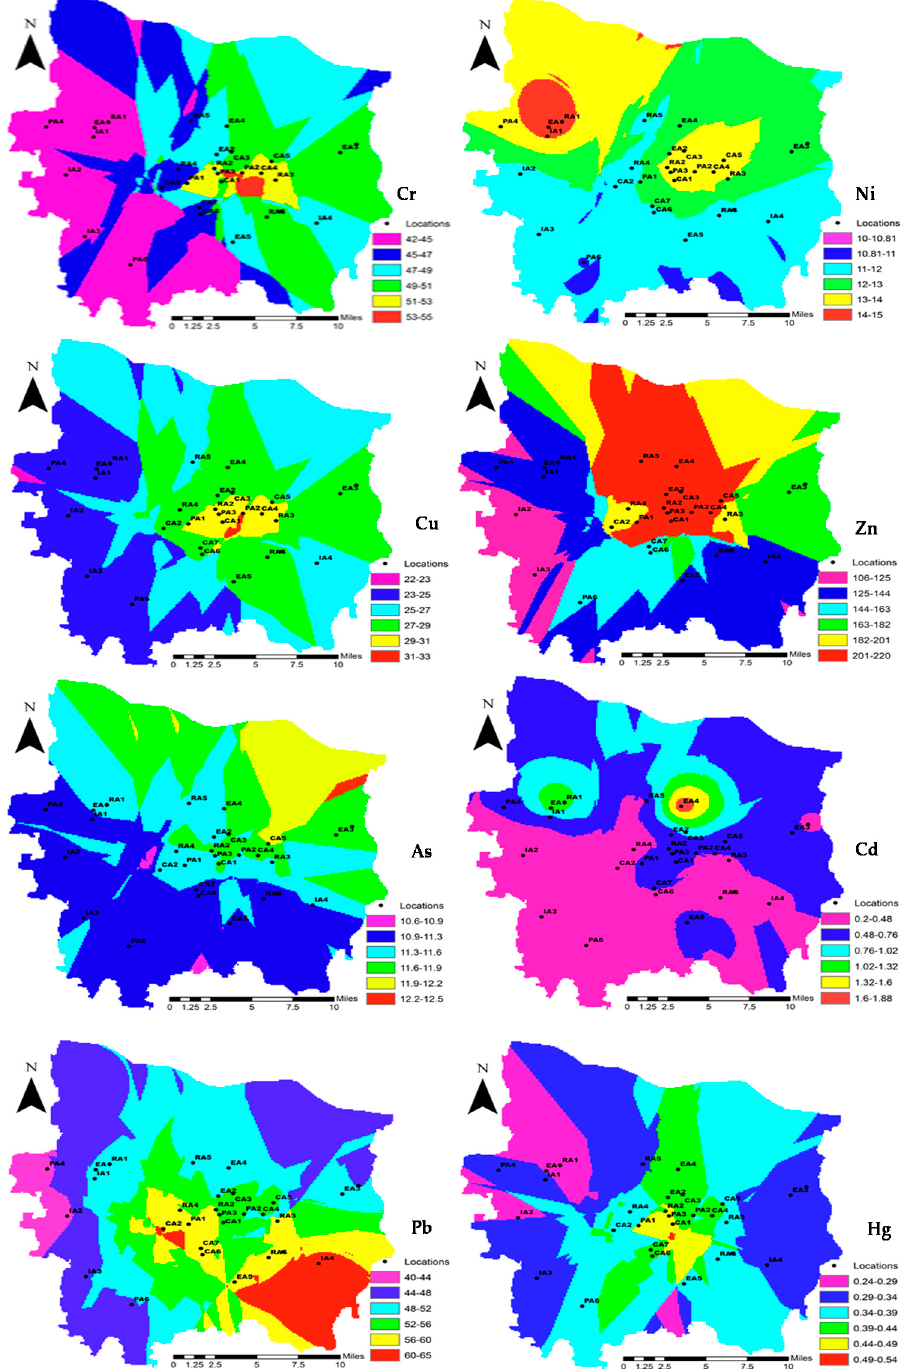
Figure 2. Geochemical mapping of heavy metal concentrations (mg/kg) .